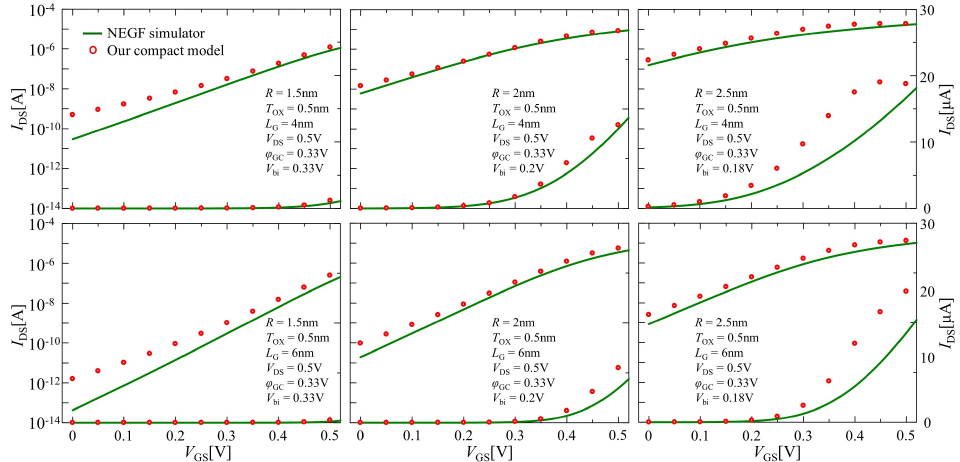
Figure 9. Comparison results between the compact model (open circle) considering the Landauer formula and NEGF simulation (solid line) for drain current characteristic calculations in all operat- ing